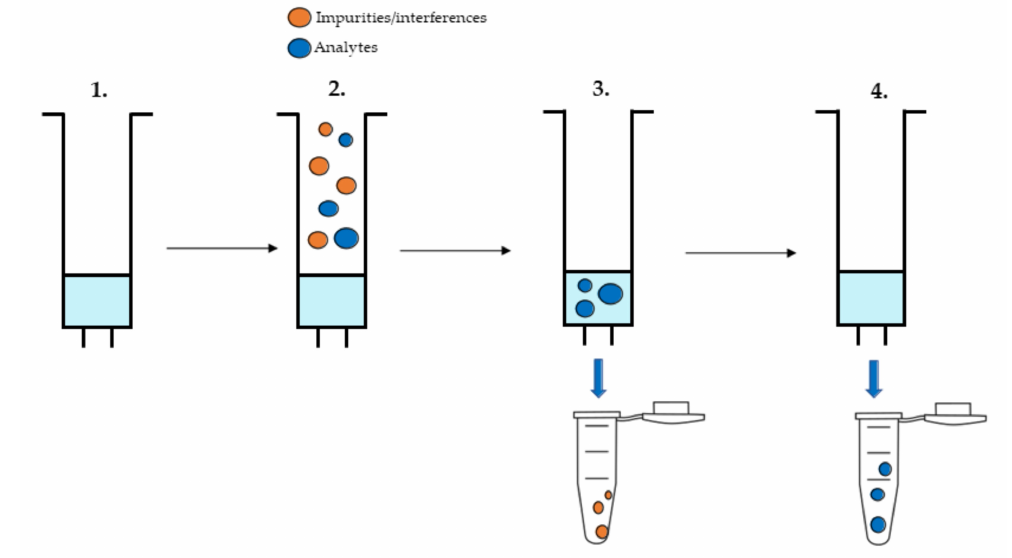
Figure 1. SPE procedure: (1) conditioning/adsorbent activation; (2) sample loading; (3) washing; (4) analytes